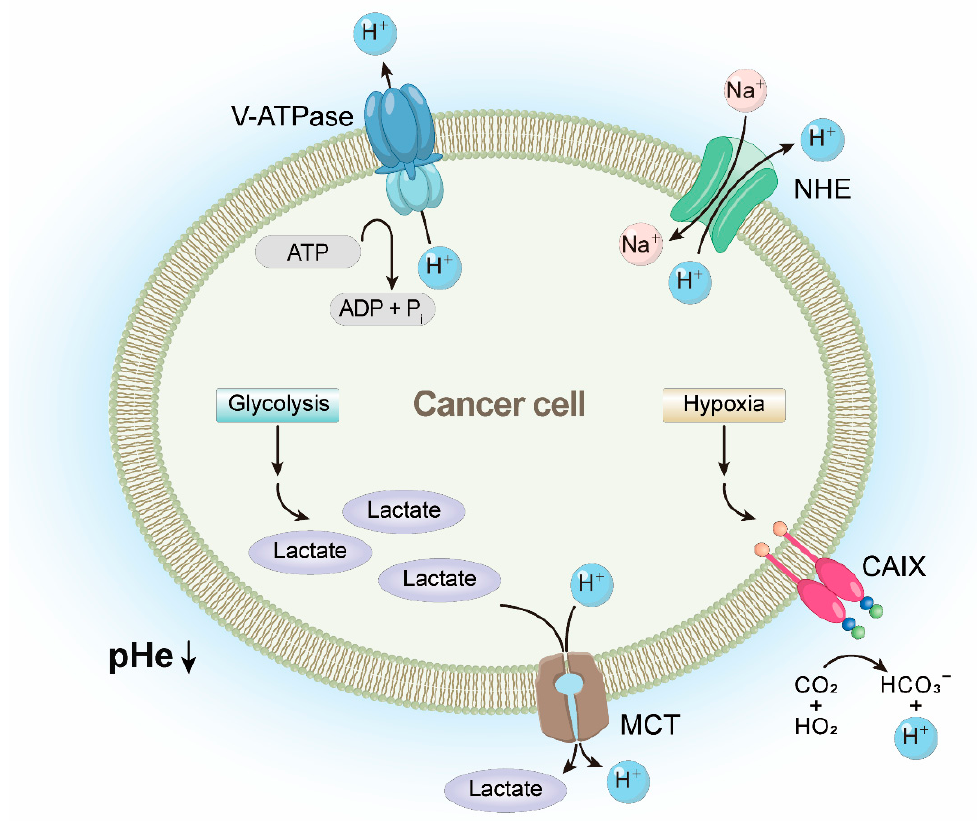
Figure 2. Extracellular acidification of the cancer cell. pHe: extracellular pH; NHE: sodium-hydrogen exchanger; MCT: monocarboxylate transporter; CAIX: carbonic anhydrase IX.